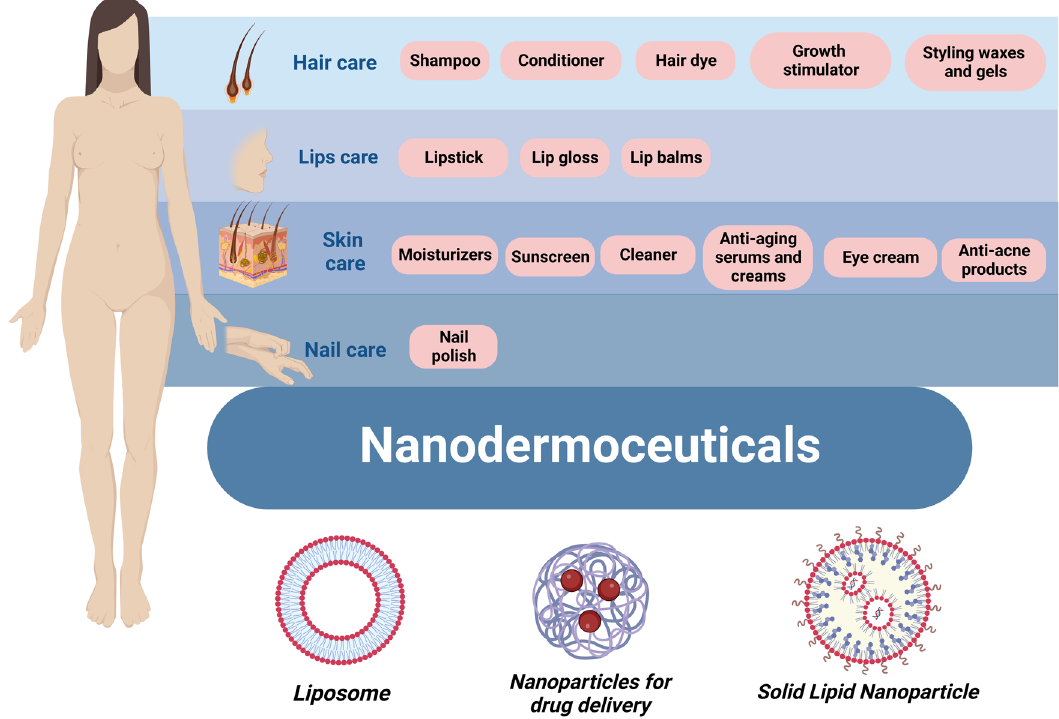
Figure 1: Main nanodermoceutics ( created by BioRender.com [ 15 ])